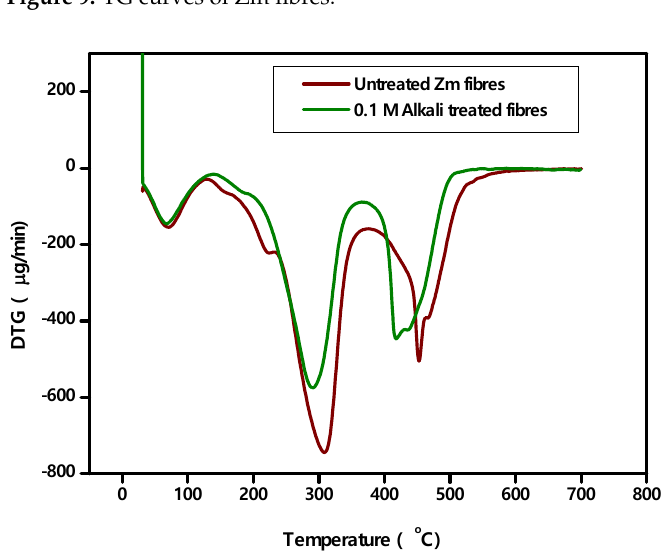
Figure 9. TG curves of Zm fibres.